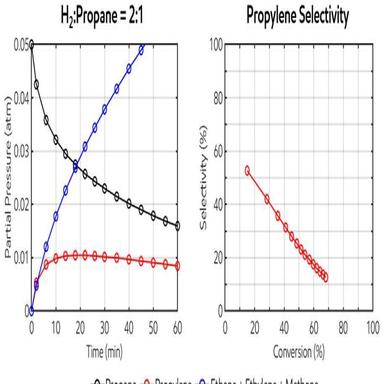
Propane reactivity on Pt-only at 550 C at a H2:propane ratio of 2:1. Plots show hydrocarbon partial pressure (black: propane; red: propylene; blue: sum of ethane, ethylene and methane) as a function of time (left), and propylene selectivity as a function of conversion (right). (For interpretation of the references to colour in this figure legend, the reader is referred to the web version of this article.)